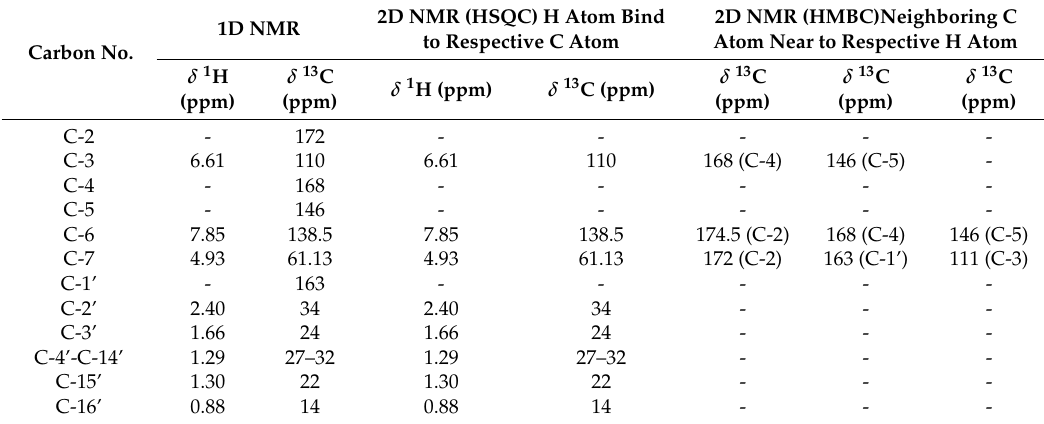
Table 2. The 1 H-NMR, 13 C-NMR with HSQC and HMBC analysis for 7- O -KAP.